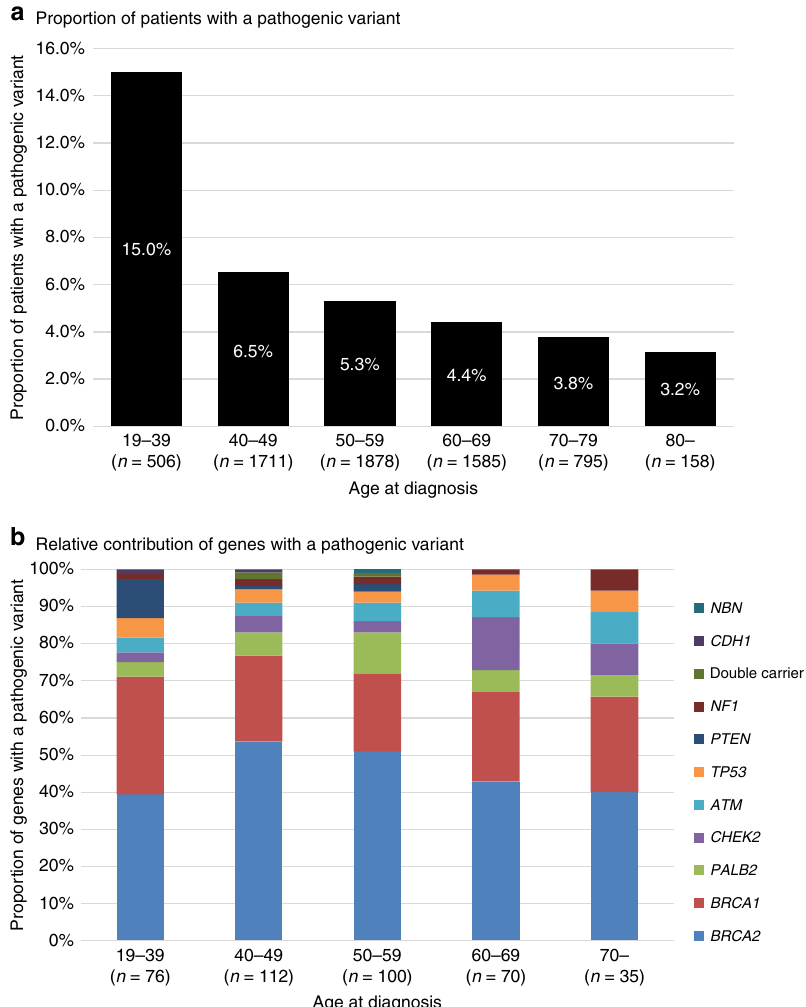
Fig. 2 a Proportion of patients with pathogenic variants and b relative contribution of genes by the age at diagnosis of breast cancer women in 10-year-age groupings. a Proportion of patients with a pathogenic variant signi fi cantly decreased with advancing age (Cochran-Armitage test, P = 1.50 × 10 − 15 ). b Color indicates each gene as shown in the right legend